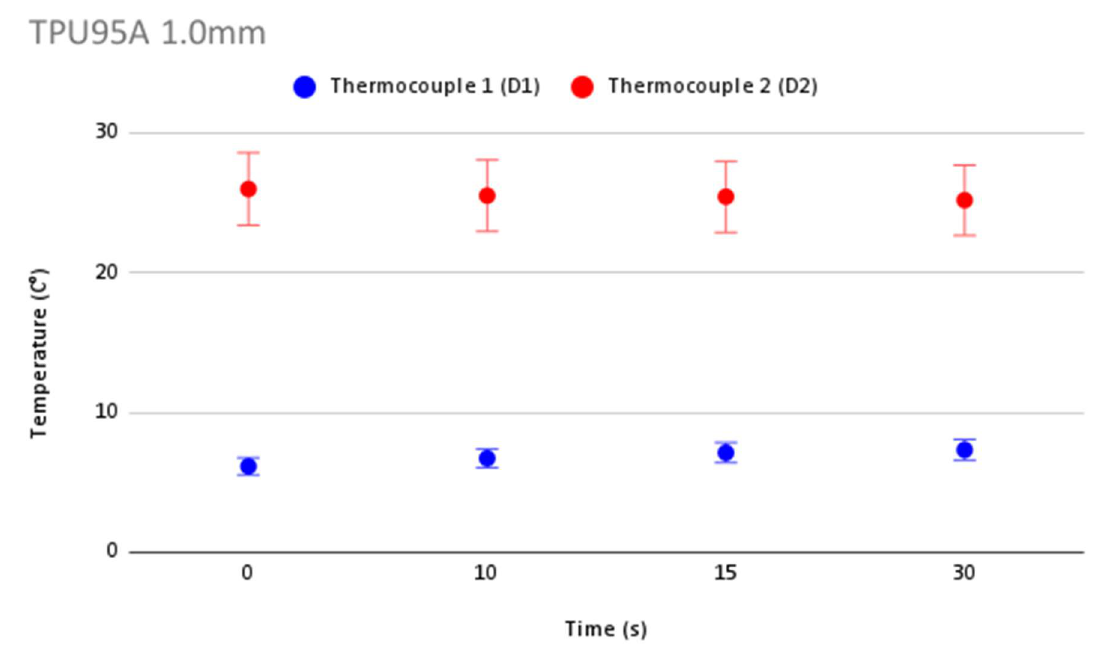
Figure 9. Repeatability of temperature measurements and error bars for TPU95A of 2.5 mm. Repeat- ability of temperature measurements and error bars for TPU95A of 2.5 mm.